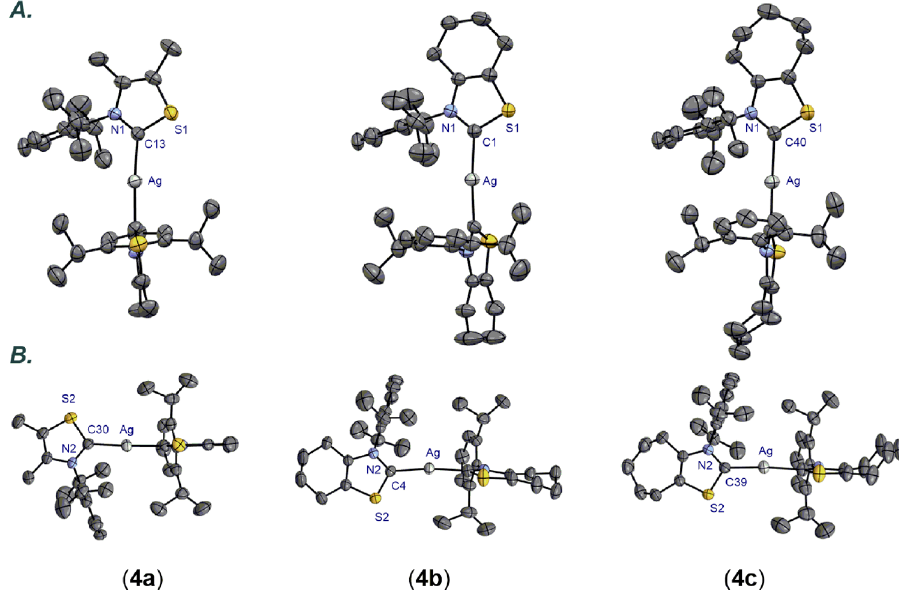
Fig. 4 X-ray crystal structure of Ag(I) complexes 4a-4c. Two views: front ( A . top); side ( B . bottom). Hydrogen atoms and counterion have been omitted for clarity. Selected bond lengths [Å] and angles [°]: 4a : Ag – C13, 2.082(3); Ag – C30, 2.086(3); N1 – C13, 1.335(4); N2 – C30, 1.337(4); S1 – C13,